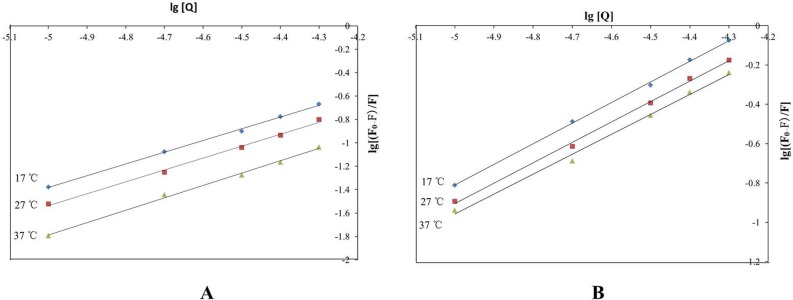
Plot of log [(F0-F)/F] vs log [Q] at different temperatures of cordycepin and has (A); Plot of log [(F0-F)/F] vs log [Q] at different temperatures of HEA and has (B).